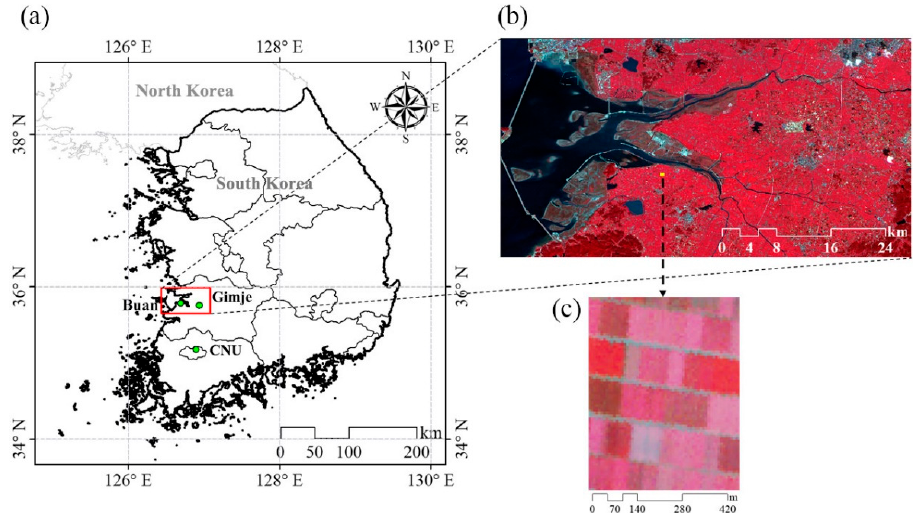
Figure 1. A shape map of South Korea and three study sites at Buan (top left circle) and Gimje (top right circle), Chonbuk and at Chonnam National University (CNU) in Gwangju (bottom circle), respectively ( a ) and a pseudo-coloured RapidEye satellite image ( b ) and a subset imagery ( c ) taken on 13 September 2014. The map ( a ) was produced using ArcGIS (ESRI, Inc., Redlands, CA, USA) and the RapidEye images were reproduced using ENVI (Harris Geospatial Solutions, Inc., Broomfield, CO,